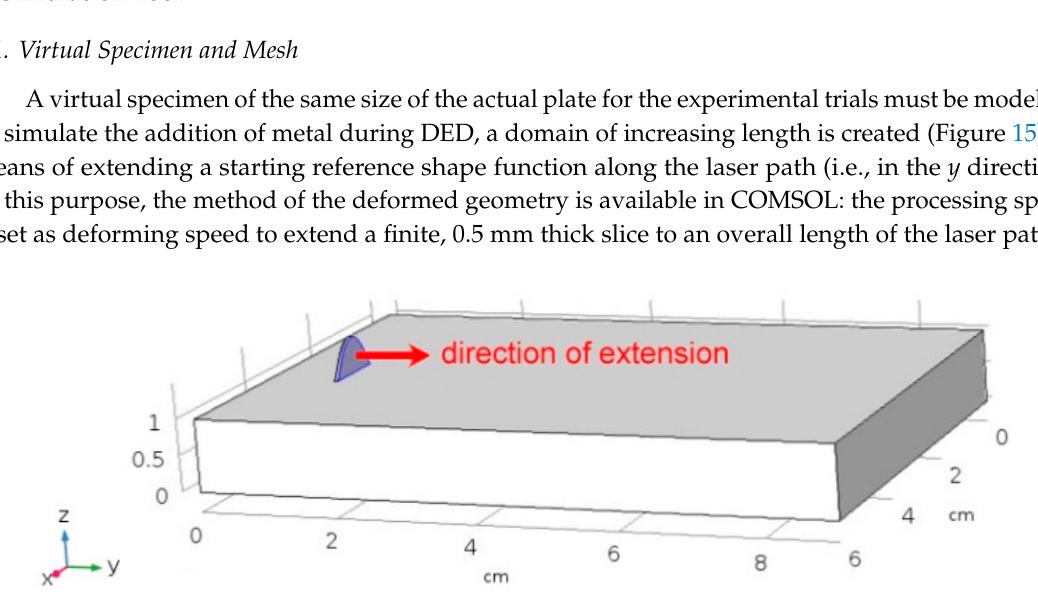
Figure 15. Implementation of a deformed geometry to result in the addition of metal.